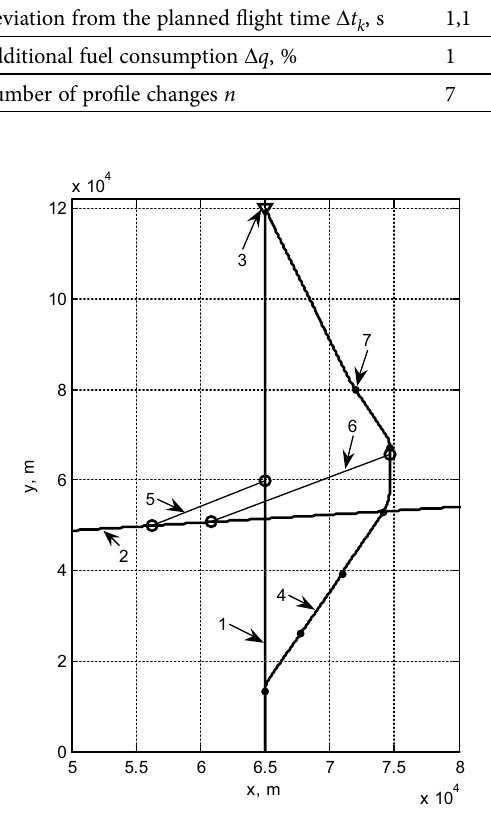
Fig. 4. Aircraft flight trajectories when resolving the conflict situation: 1 – planned flight trajectory of Aircraft 1; 2 – planned flight trajectory of Aircraft 2; 3 – check point; 4 – optimal conflict-free flight trajectory of aircraft 1; 5 – the minimum distance between two aircraft when detecting the conflict; 6 – the minimum distance between two aircraft when resolving the conflict; 7 – states at different stages